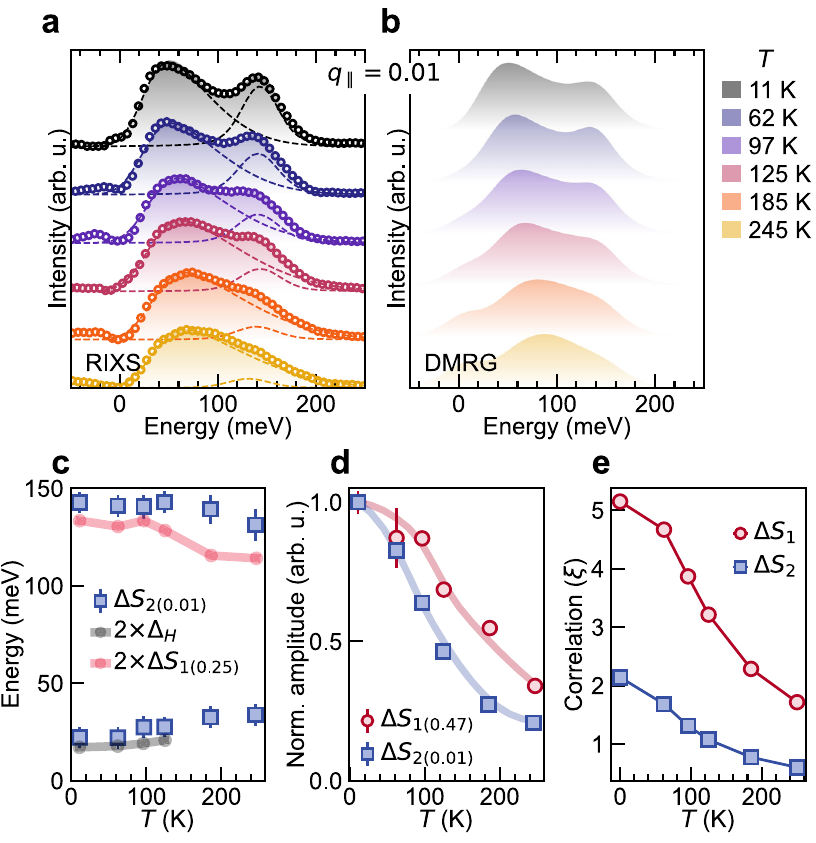
Fig. 4 Thermal stability and correlations of quadrupolar excitations in Y 2 BaNiO 5 . a RIXS spectra (open circles) at q ∥ = 0.01 with fi tted elastic contributions subtracted, at different temperatures. The Δ S 2 contributions have been fi tted to extract the positions and amplitudes of the two branches shown by dashed lines (see Methods). The shaded regions show the complete fi t pro fi les. b Δ S 2 pro fi les obtained from DMRG for corresponding temperatures. c Energy variations with temperature of the two branches of the Δ S 2 excitations extracted from RIXS shown in panel a . Blackline with circles shows the thermal variation of twice the Haldane gap energy obtained from ref. 5 . Redline with circles shows the thermal variation of twice the Δ S 1 peak energy at q ∥ = 0.25. d Thermal variation in amplitudes of Δ S 1 peak and the high energy peak of the Δ S 2 extracted from fi tted RIXS spectra at q ∥ = 0.47 and 0.01, respectively, normalised to corresponding amplitudes at 11 K. e Dipolar and quadrupolar correlation lengths for Δ S tot = 1 and 2 excitations obtained from DMRG static dipolar and quadrupolar correlation functions (see Methods). Error bars are least-square- fi t quadrupolar excitations in S = 1 FeI 2 appear in INS only due to their hybridisation with dipolar excitations through anisotropic spin-exchanges 14 . In the presence of a strong anisotropy, bound magnetic excitations from Δ S tot = 2 spin- fl ips at energies higher than the two-magnon continuum have also been observed in S = 1 spin chains using high- fi eld electron spin resonance 36,37 .